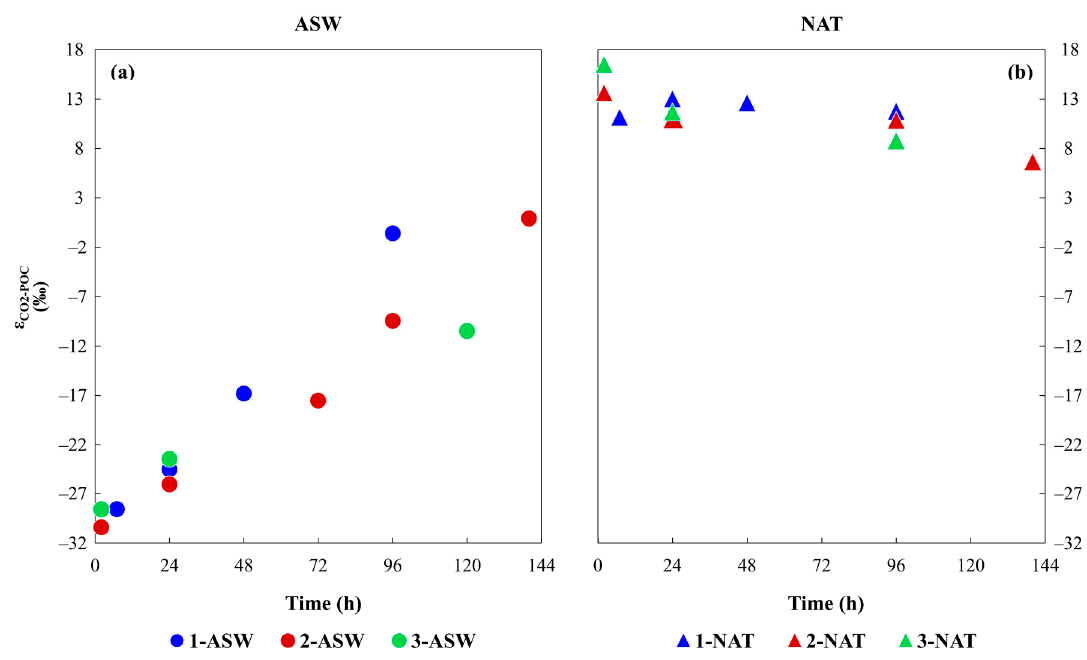
Figure 5. Time variation of the isotopic enrichment factor ( ε CO2-POC ) of T. rotula in the three culture experiments calculated on δ 13 C CO2(aq) . Circles ( a ) represent the artificial seawater medium (ASW) and triangles ( b ) the natural seawater medium (NAT). Blue symbols represent the first experiment (EXP-1), red the second experiment (EXP-2) and green the third experiment (EXP-3).